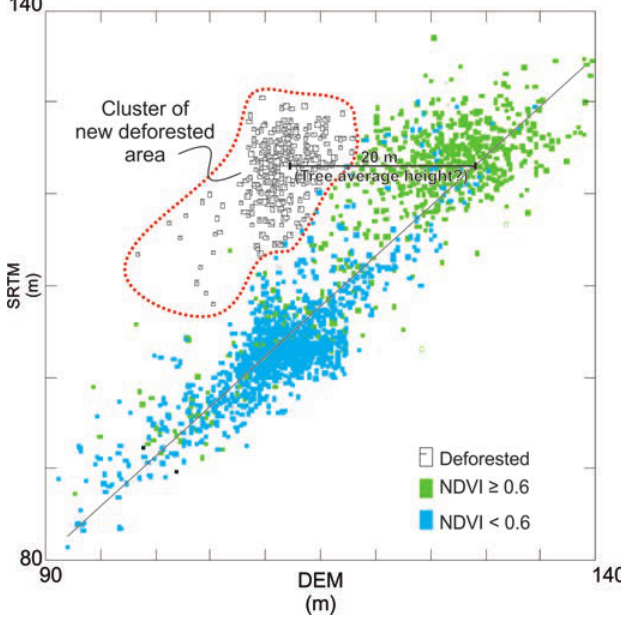
Figure 3 - Airborne DEM and SRTM DEM goodness-of-fit plot with moderate to strong correlation for most samples. The marked field probably corresponds to a deforested area between the two surveys. The point dispersion around the regression line is consistent with the instrumental error estimation of the elevation survey. Green rectangles represent areas with NDVI over